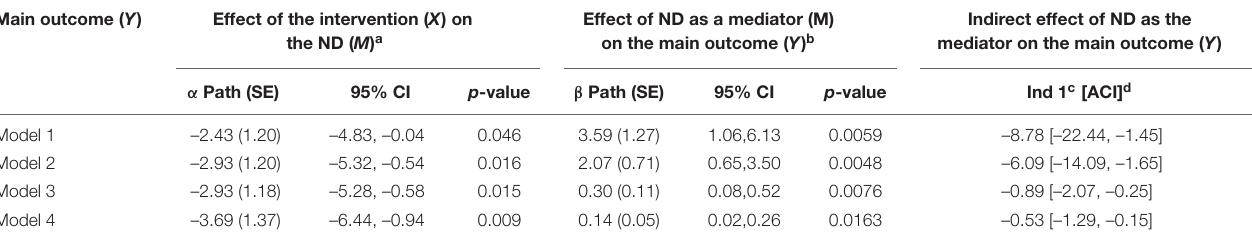
TABLE 4 | Nicotine dependence as a mediator of the effect of Project EX, compared with a control group, on tobacco use measures by the 12-month follow-up among adolescents from Spain. Main outcome ( Y ) Effect of the intervention ( X ) on Effect of ND as a mediator (M) Indirect effect of ND as the the ND ( M ) a on the main outcome ( Y ) b mediator on the main outcome ( Y